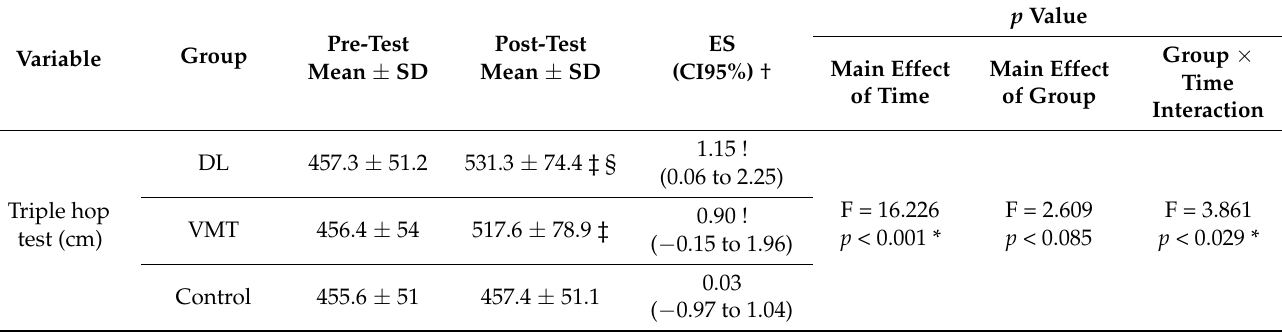
Table 5. Between and within-group changes of triple hop test